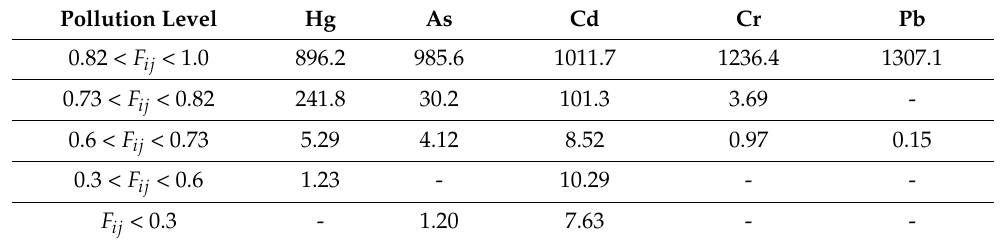
Table 6. Area statistics of soil environmental quality grade.